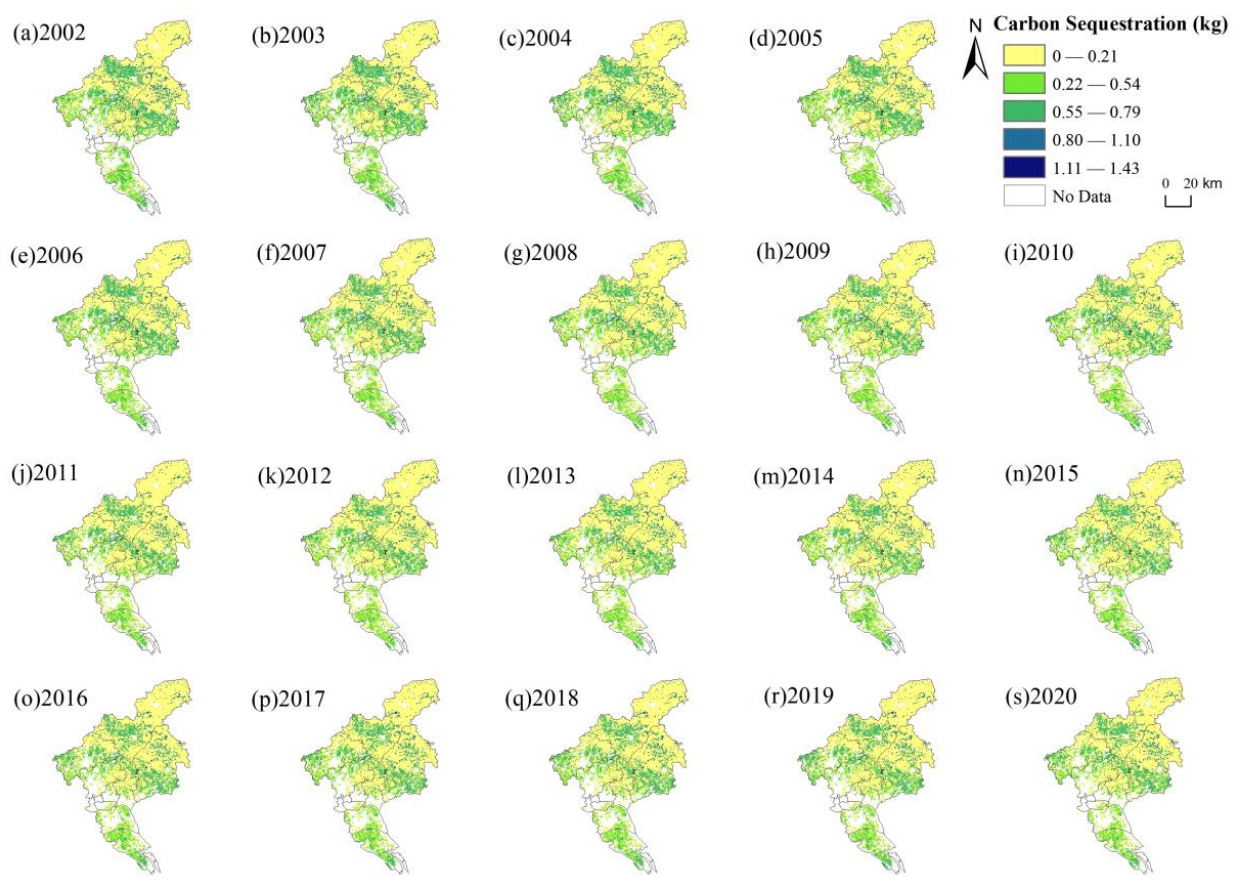
Figure 7. Carbon sequestration of urban agriculture in Guangzhou’s districts from 2002 to 2020. Table 3. Results of panel unit root